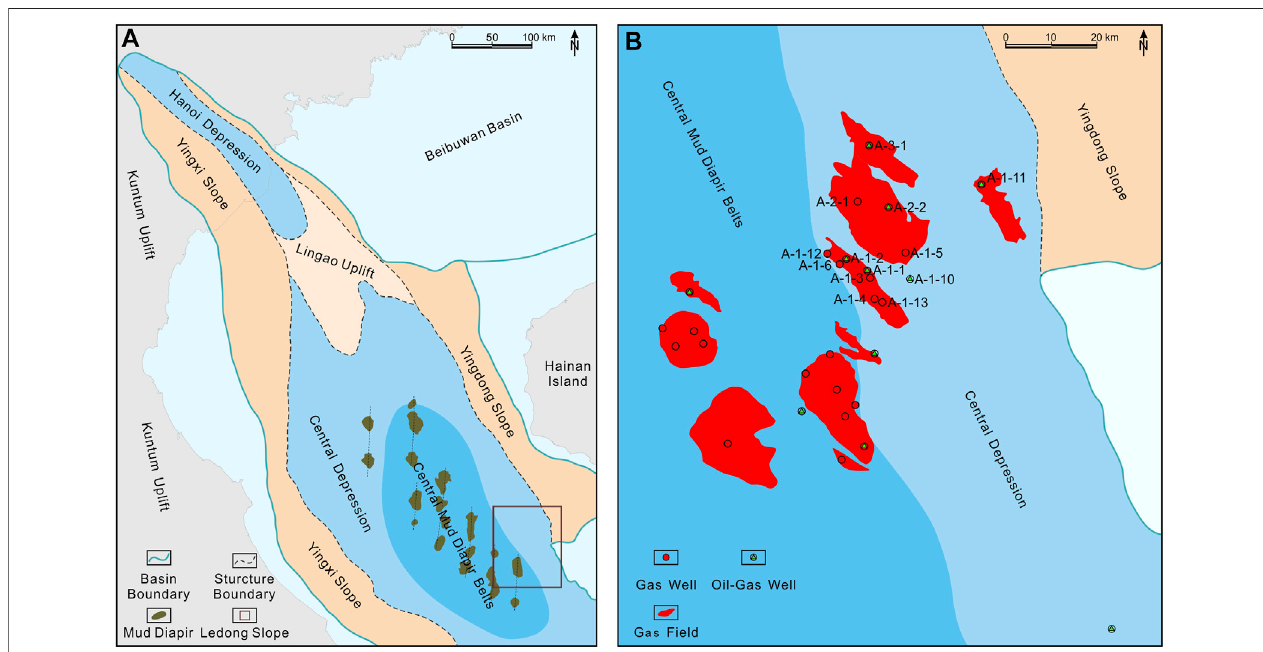
FIGURE1| Structuraldivision ofthe Yinggehai Baisnand well location ofthe LD-A gas fi eld. (A) Simpli fi ed structural map ofthe Yinggehai Basinand theLD-A Gas Field, and (B) the distribution of wells in the LD-A gas fi eld.